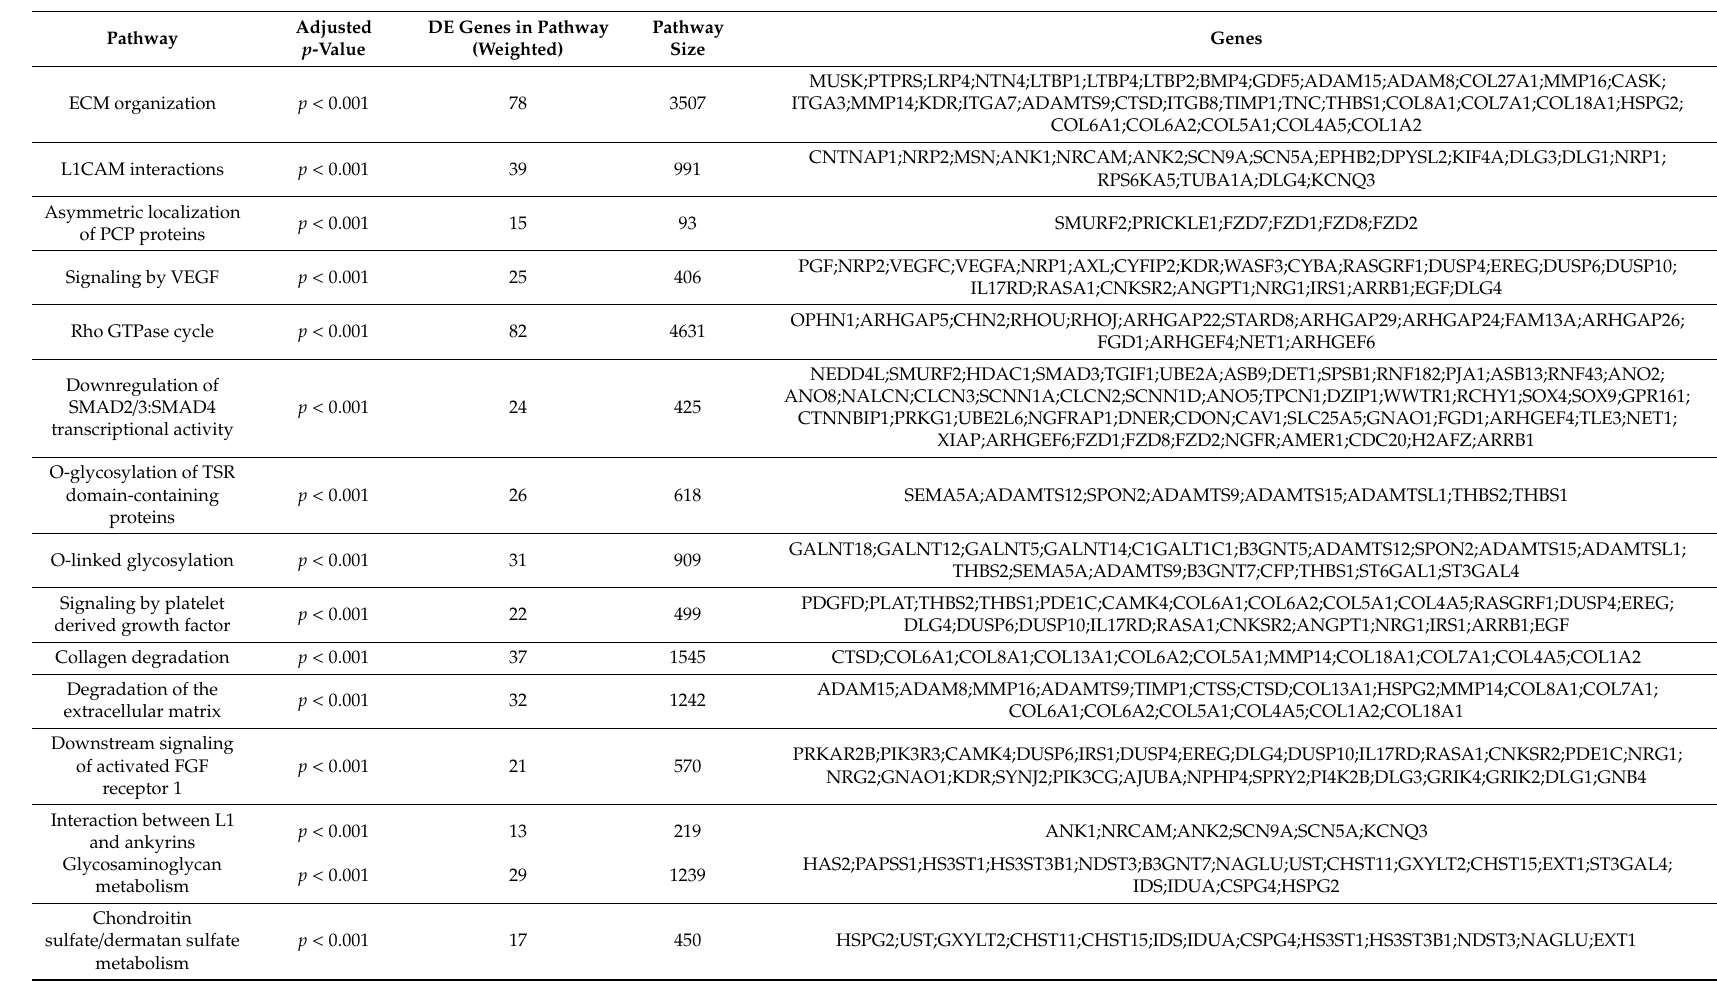
Table 2. Down-regulated pathways and genes in peptide-resistant MDA-MB 231 breast cancer